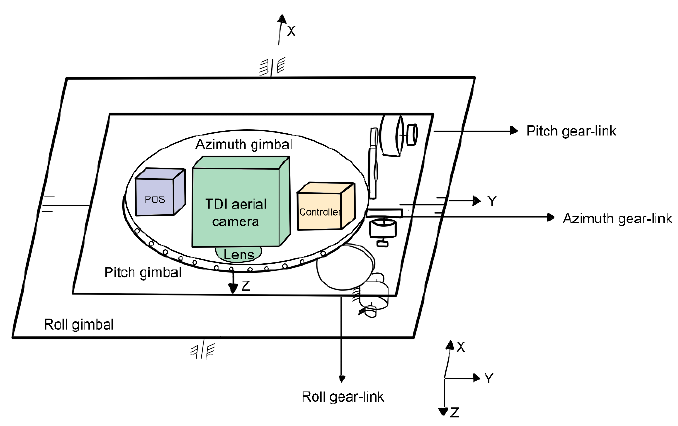
Figure 1. Principal diagram of the ARSSP.